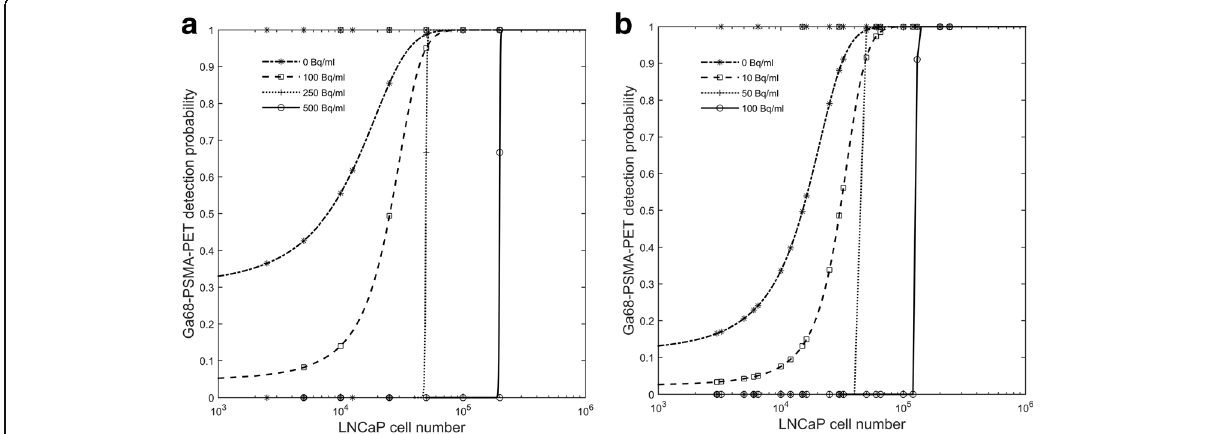
Fig. 2 Ga68-PSMA-11-PET detection probability for LNCaP cells in suspension ( a ) or incubated as spheroids ( b ). The markers show the binary classification using the Rose criteria with CNR > 3 and the lines the binomial regression curves at different background